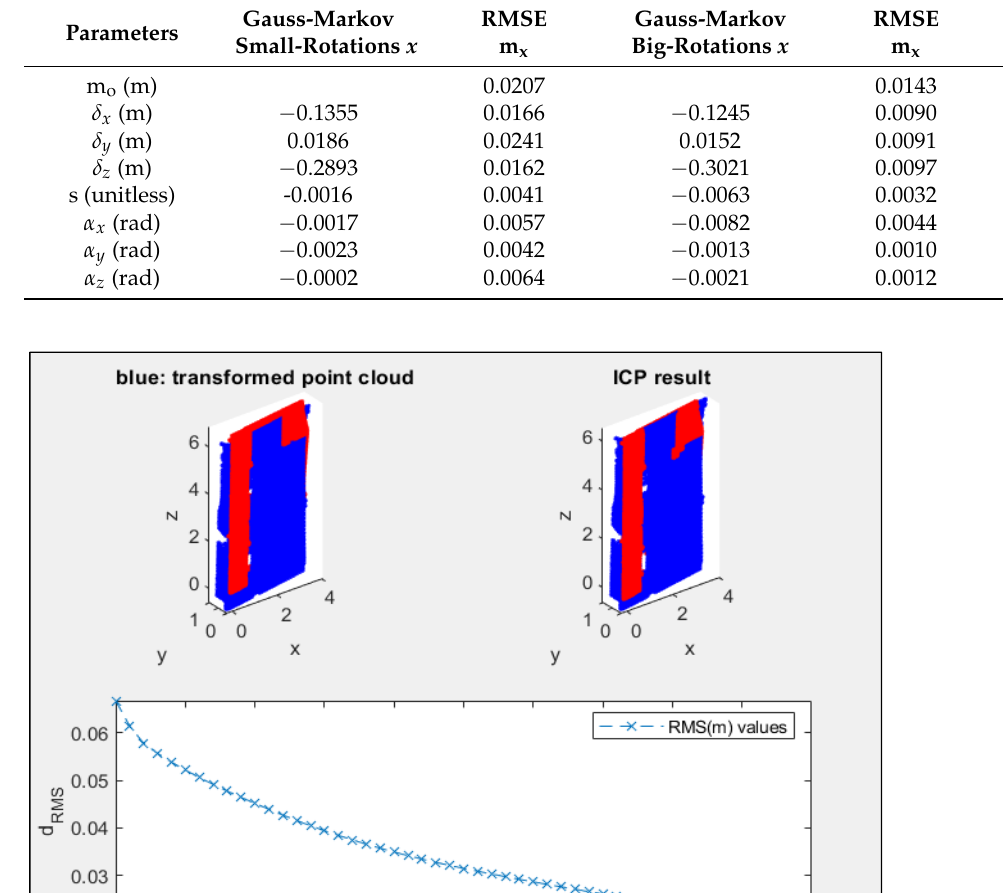
Table 5. Stanford bunny sculpture: transformation parameters ( (cid:2206) ) with their RMSE ( m x ) in coarse registration with the new algorithm. Parameters Gauss-Markov Small-Rotations (cid:2206)